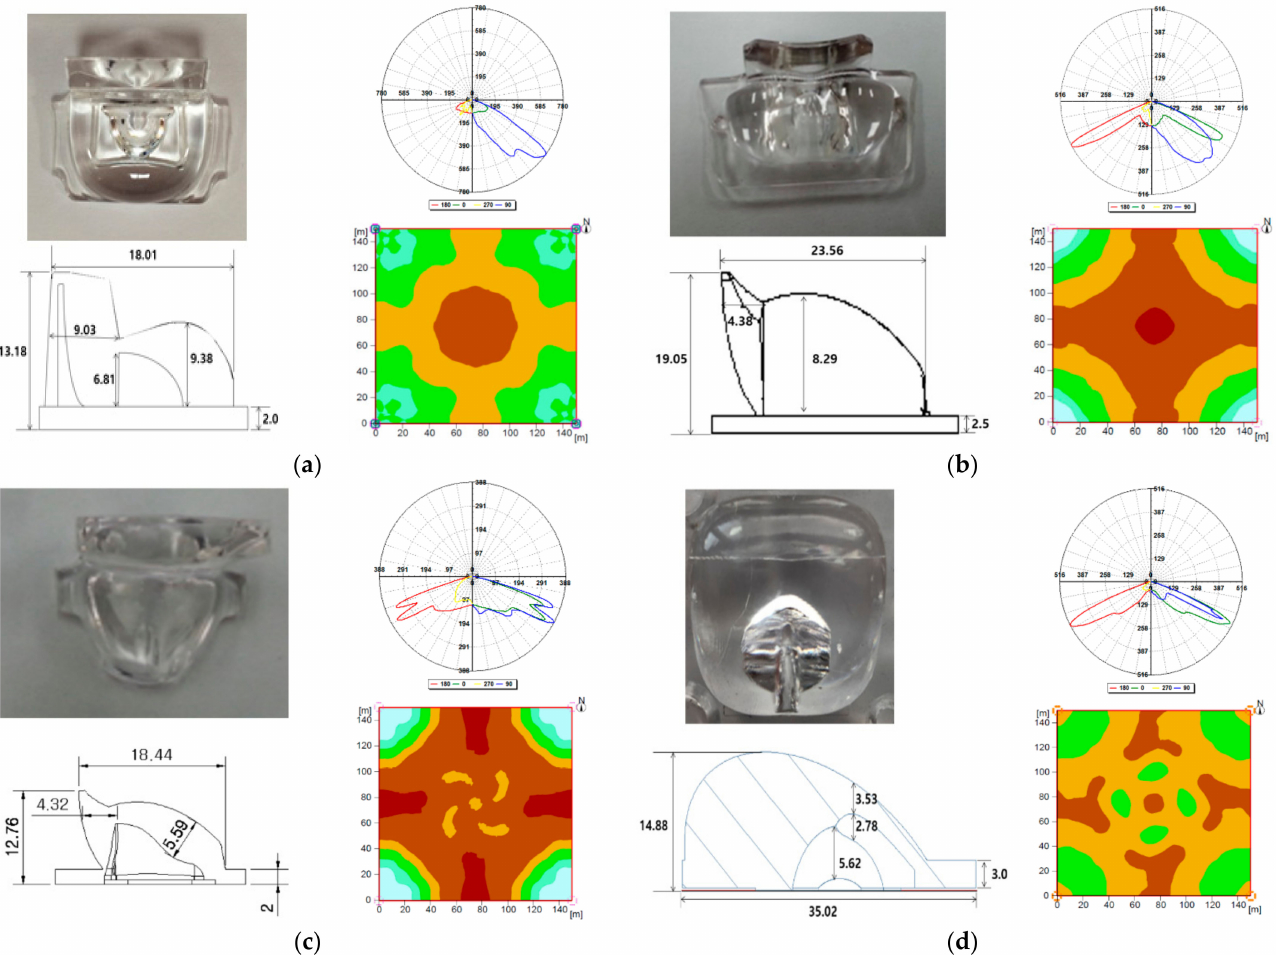
Figure 3. Design drawing, photo of fabricated optical lens, measured luminous intensity distribution, and simulated light distribution of lens type A ( a ), B ( b ) C ( c ), and D ( d ) (the parameters listed in Table 1 were used for the simulation of light